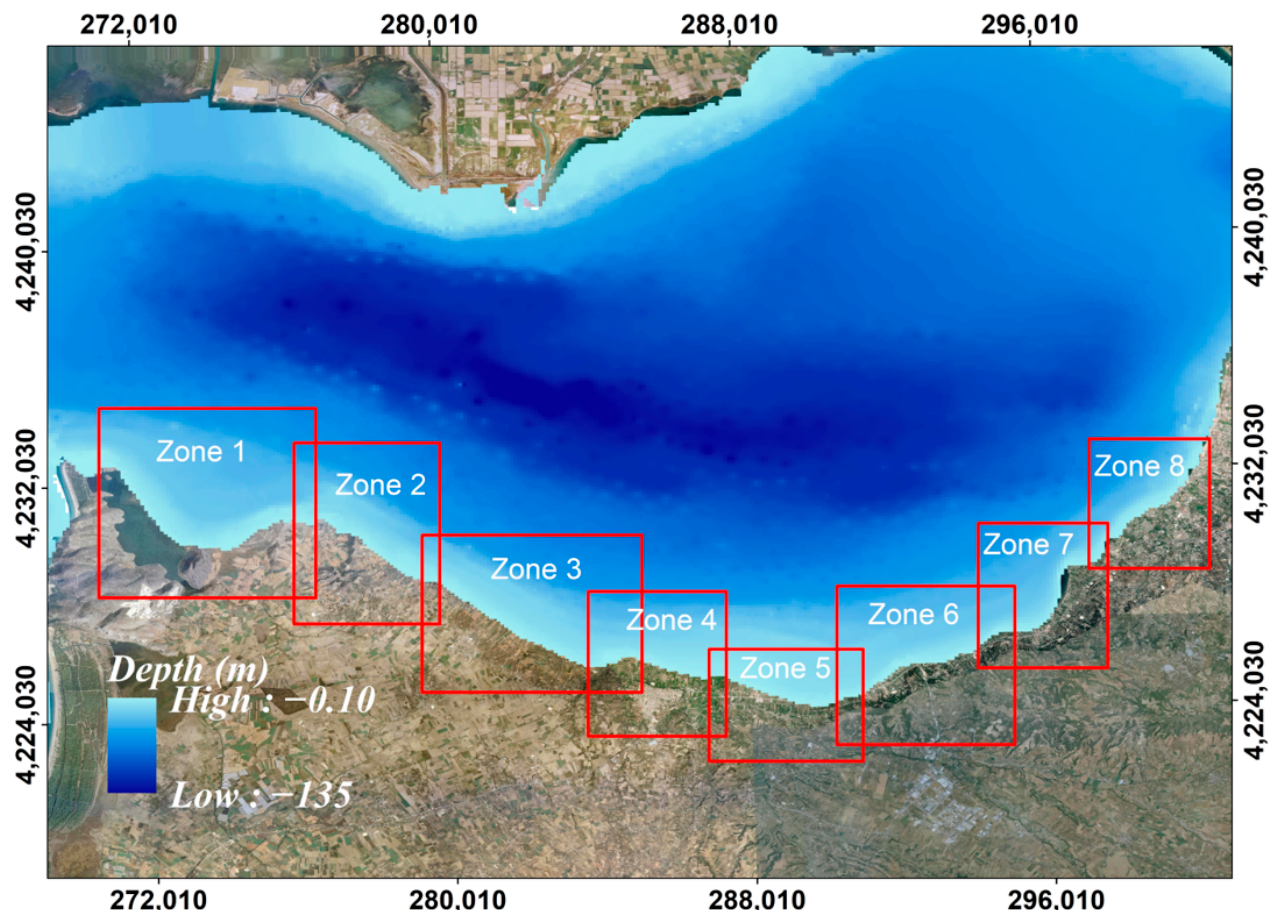
Figure 8. Map of the southern shoreline of the research area divided into 8 coastal independent zones, with the bathymetry used in the numerical simulations (stages 2, 3, and 4).